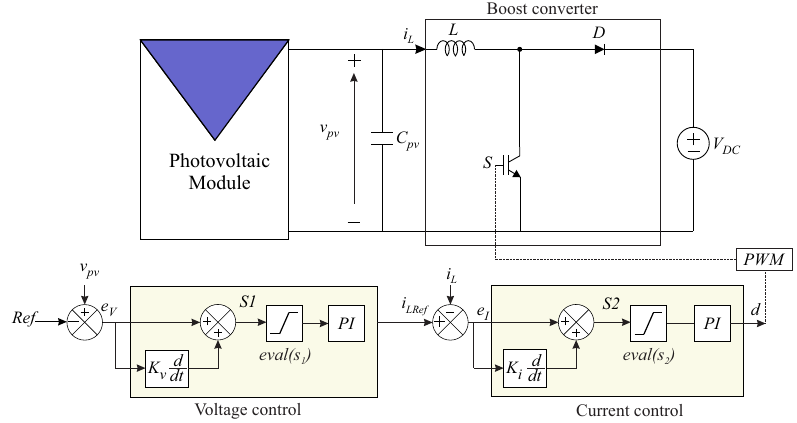
Figure 1. Block diagram of the